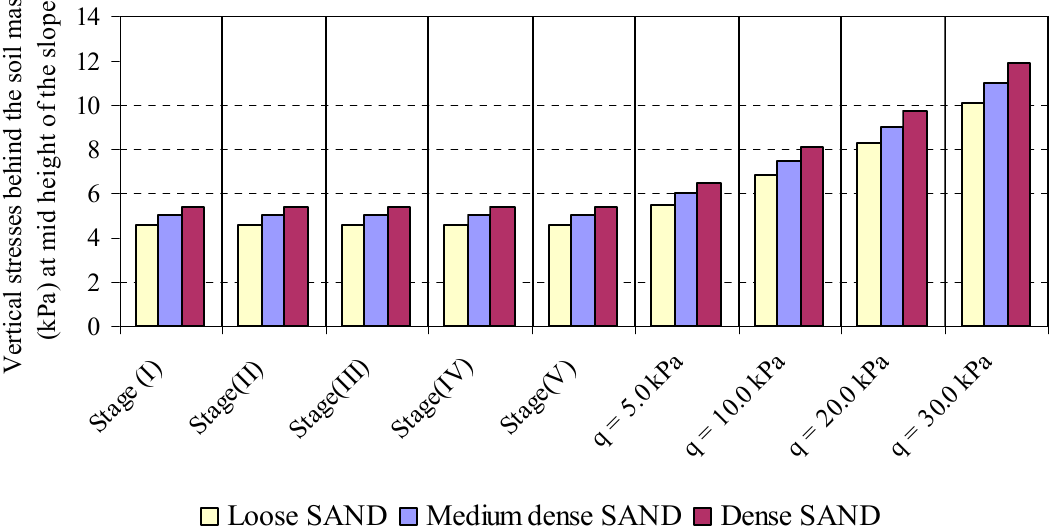
Figure 11. Influence of soil density on vertical stresses behind the nailed soil mass.